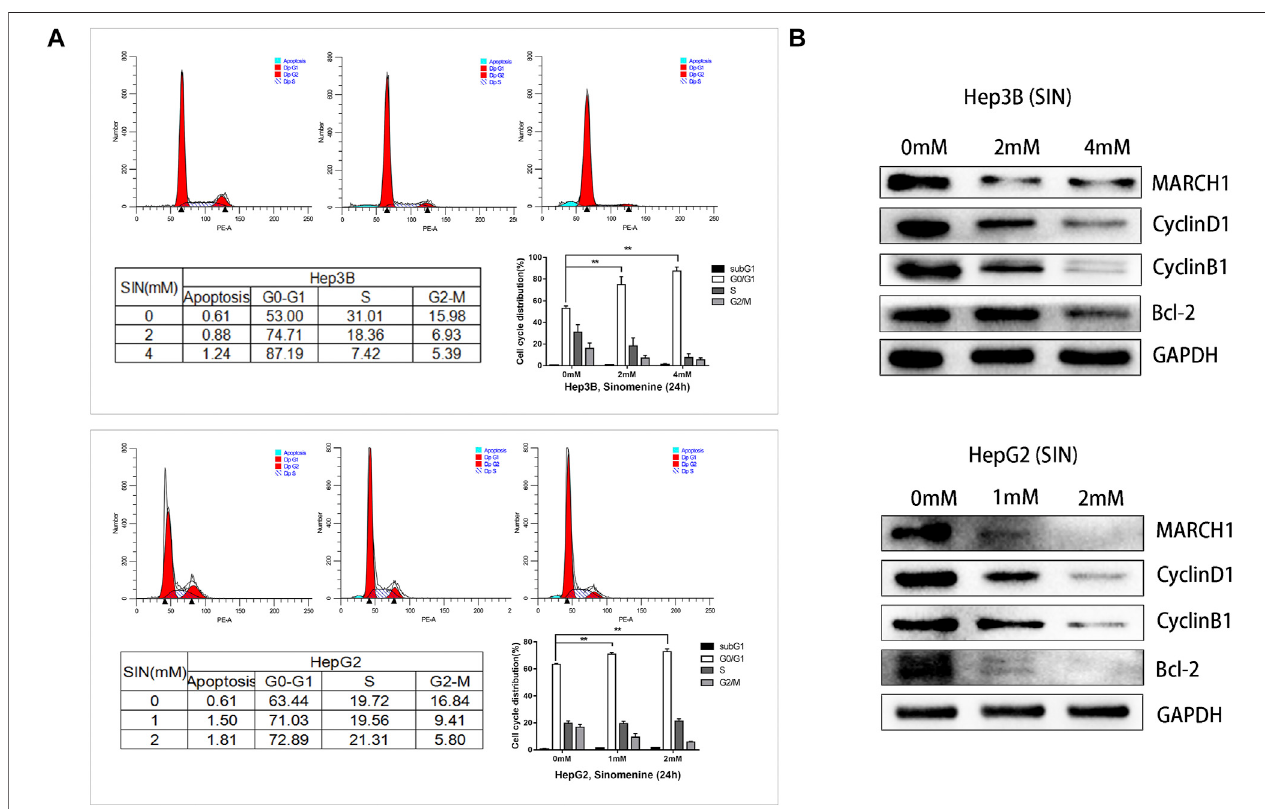
FIGURE 4 | SIN Causes HCC Cell Cycle Arrest. (A) Flow cytometric analysis on cell cycle of Hep3B and HepG2 cells treated with or without SIN, and data are presented in tables and statistical graphs. (B) Cell cycle-related proteins including MARCH1, CyclinD1, CyclinB1 and Bcl-2 measured by Western Blotting. 0 mM as